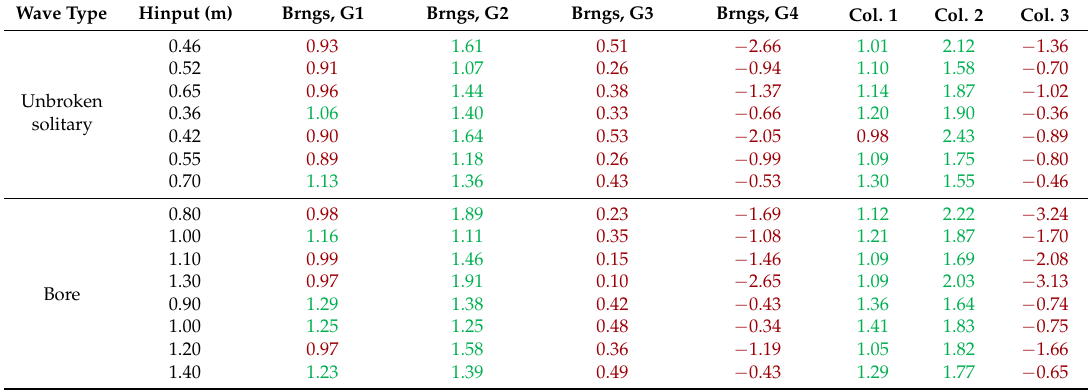
Table 4. Ratio of bearing and column-bent cap connection uplift forces calculated from the improved simplified method (with applied moment) to the respective values recorded in the experiments. Wave